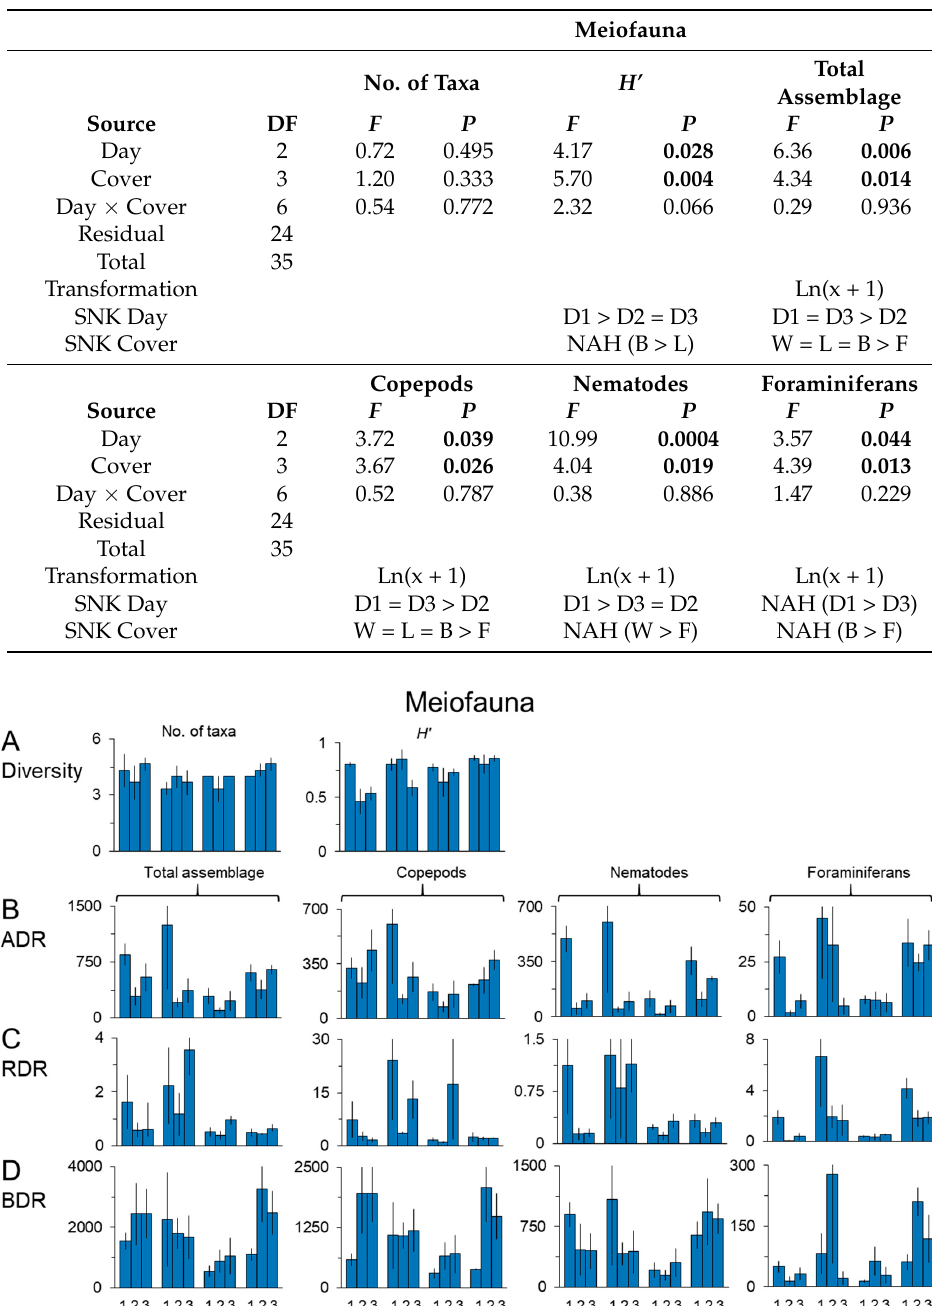
Table 2. ANOVA results for meiofauna in traps: number of species, H’, and absolute dispersal rates (ADR). Transformations indicated where applied. Significant differences ( P < 0.05) are in bold and SNK results are presented. NAH = no alternative hypothesis; the two groups with the largest and smallest means within the factor were significantly different, and no further resolution among the groups in that factor could be determined. L = live mussels, W = whole shells, F = fragmented shells, B = bare sediment. D1 = Day 1, D2 = Day 2, D3 = Day 3.